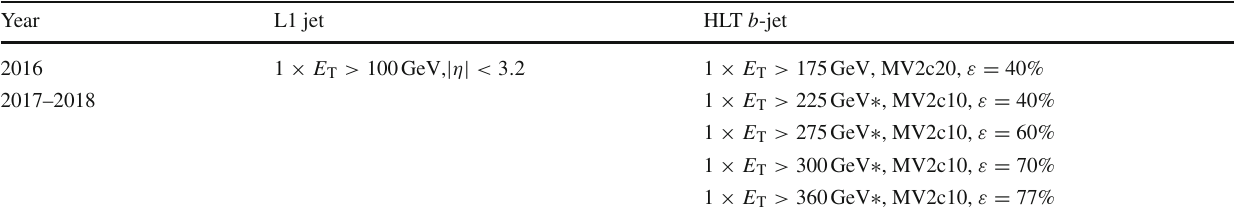
Table 2 Details, by year, of the lowest-threshold unprescaled single- b -jet triggers. The minimum ( b -)jet E T , | η | , and b -tagging require- ments are specified for each item. HLT b -jets are required to be within